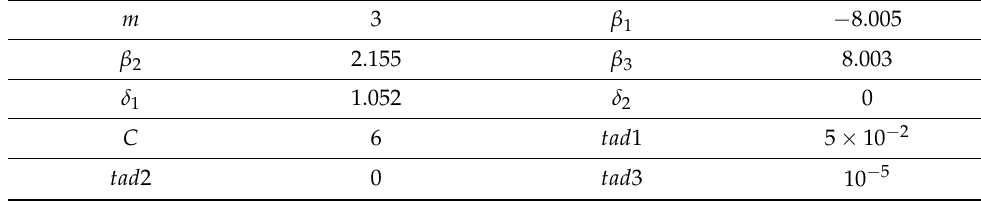
Table 2. Tuning parameter and constant value for fitting lab result.